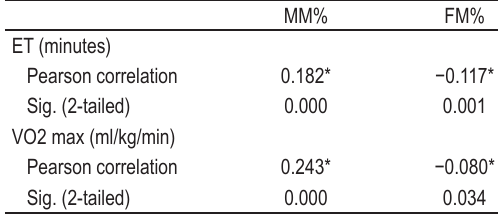
TABLE 4. Results of correlation between Bruce test